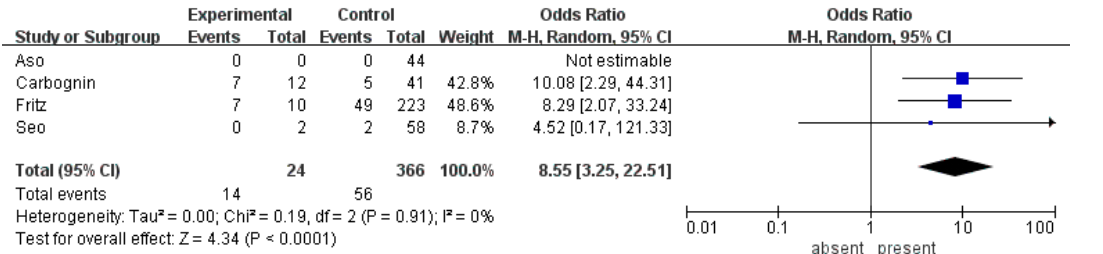
Figure 4. Forest plot demonstrates the incidence of malignancy in BD-IPMN stratified by the presence of lymphadenopathy.